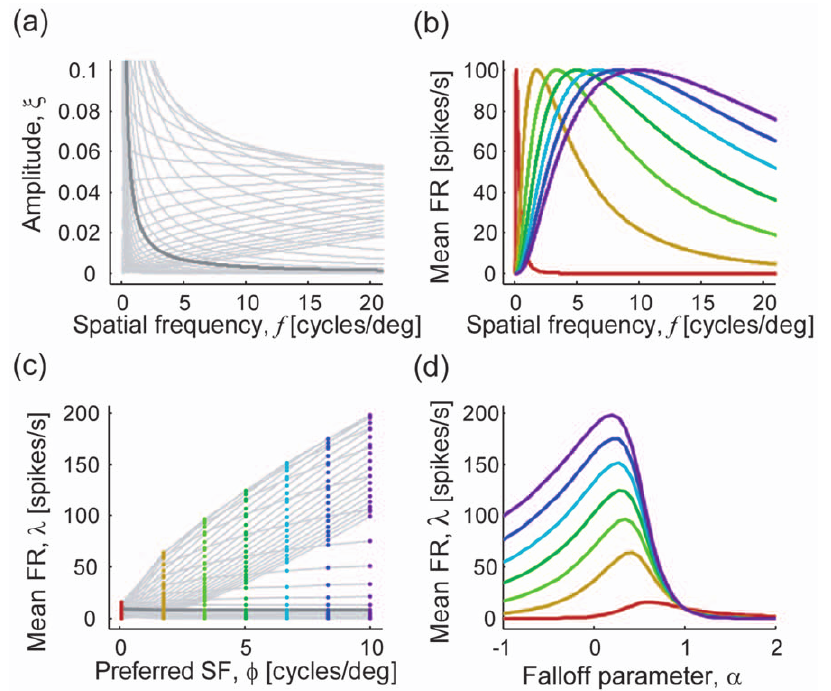
Figure 1. Modeling of visual stimuli and neuronal responses. (a) Models of amplitude spectra of images, where the amplitude spectrum of each image satisfies cf { a = z a ð Þ . Each curve represents a spectrum with a particular falloff parameter a from 2 1 to 2. Contrast-determining parameter c was set to 0.05 for each image. The thick curve represents the spectrum of an image with a ~ 1 . (b) Spatial frequency tuning of model neurons within a hypercolumn. Seven example neurons with most-preferred frequencies are spaced evenly from 0.01 to 10 cycles/deg (colored from red to indigo). The tuning curves are modeled with log Gaussian functions. (c) Demonstration of population activity evoked by the images satisfying the power law with different a values. Dot colors are matched to those in panel b. Each curve links the unit activities evoked by a common stimulus. The thick flat line represents the responses to the image with a ~ 1 . (d) Hypothetical response curves as functions of a , derived from activity profiles shown in panel c.